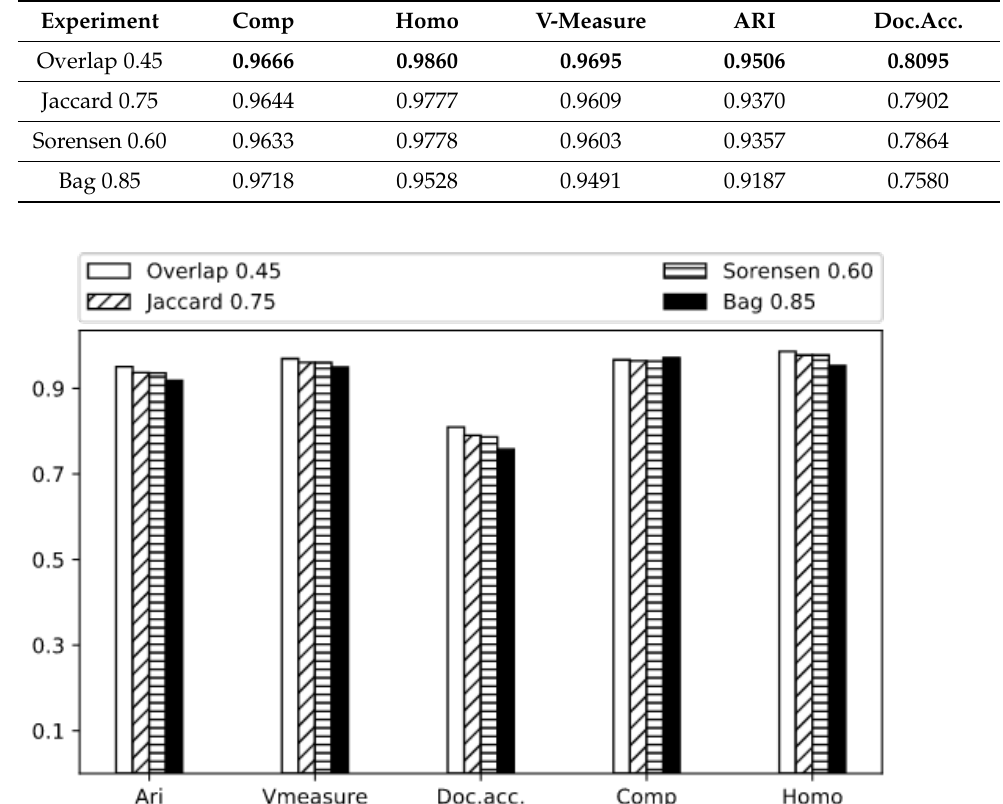
Figure 7. ARI, V-Measure, Document Accuracy, Completitude and Homogeneity for best Overlap, Jaccard, Sorensen and Bag